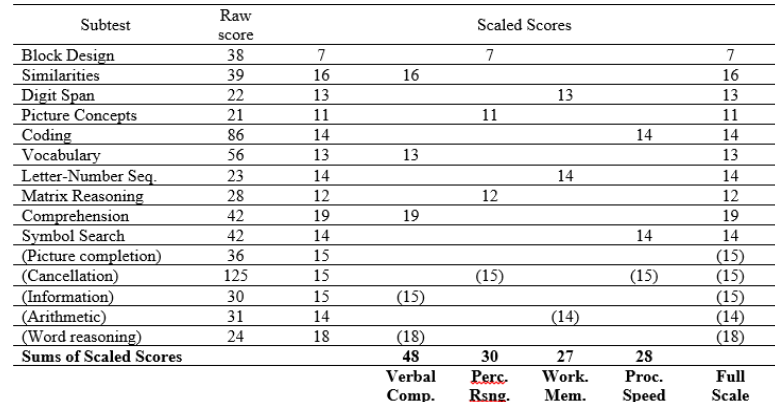
Fig. 2. Total raw score to scaled score